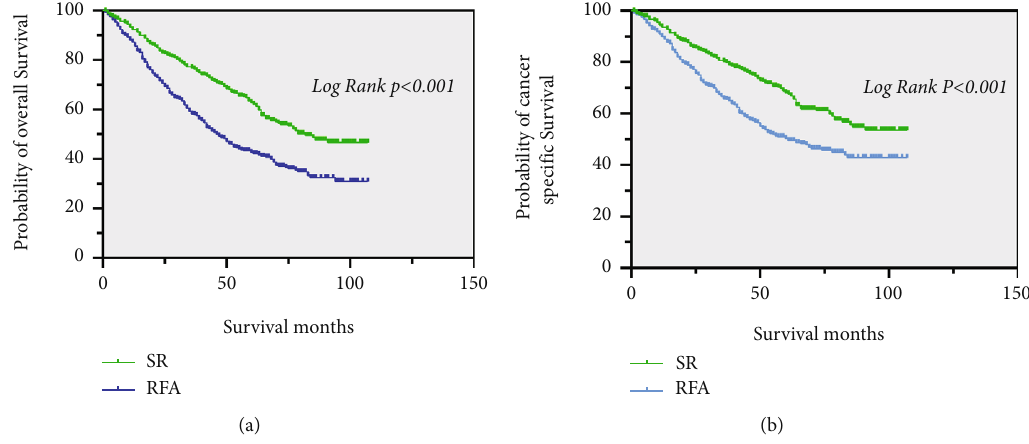
Figure 3: The Kaplan – Meier curve for OS (a) and CSS (b) after PSM for patients with SR and RFA.